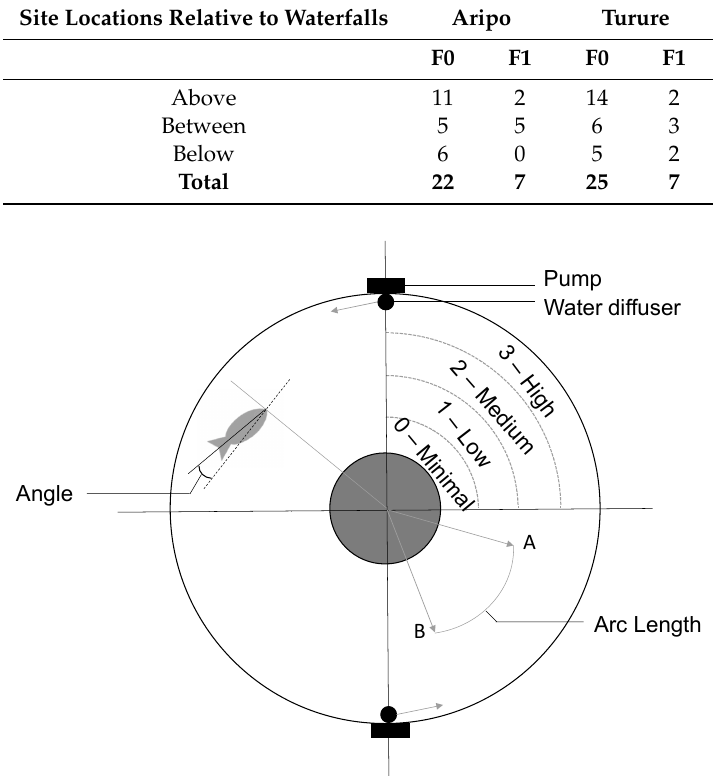
Figure 2. The experimental circular-flow tank. Dotted lines delineate different approximate flow regimes (High, Medium, Low and Minimal: upper right quadrant). Distance was measured as the arc length distance between two points (lower right quadrant). Angle was measured as the alignment of the fish against the flow (upper left quadrant). Direction of the water is given by arrows from the water diffusers. The tank dimensions were: testing chamber diameter = 65 cm; inside diameter = 25 cm, and water depth = 16 cm.